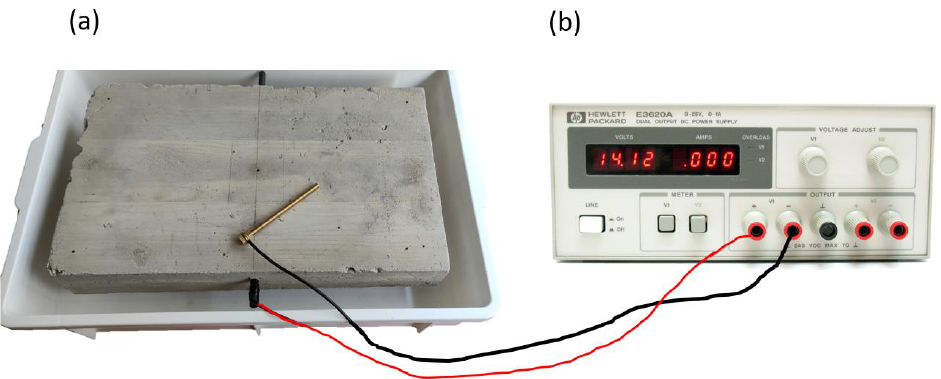
Figure 3. Accelerated corrosion tests with the impressed current technique. ( a ) The reinforced concrete sample was immersed in a solution of 5% NaCl and 95% of water. ( b ) the used Hewlett DC Power supply .